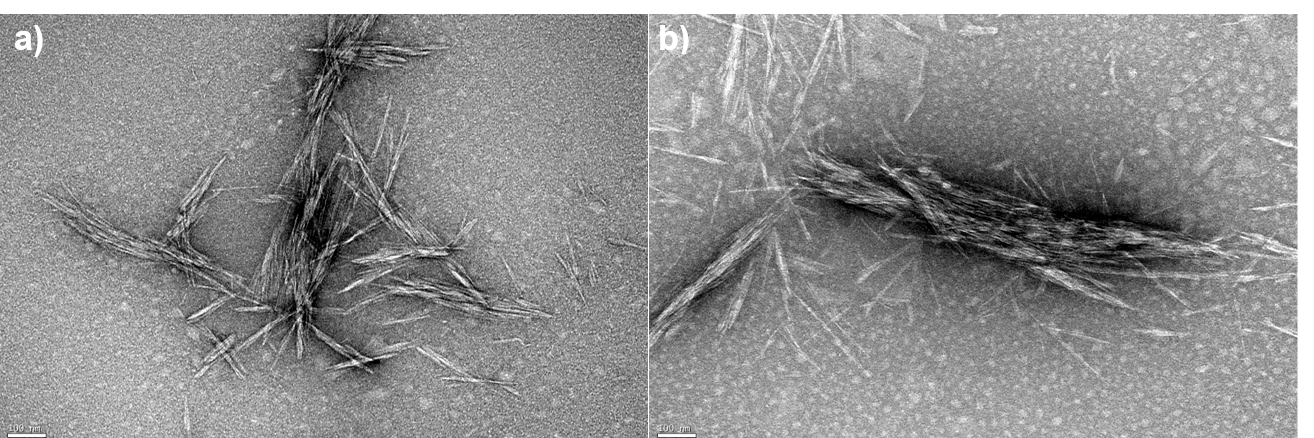
Figure 8. Scanning electron microscopy images of ( a ) free cellulose nanocrystals modified with cetyltrimethylammonium bromide (CNC-CTAB) and ( b ) CNC-CTAB encapsulating curcumin (3000×, 5 kV, 1.0 Pa, scale bar equals 50 µm).